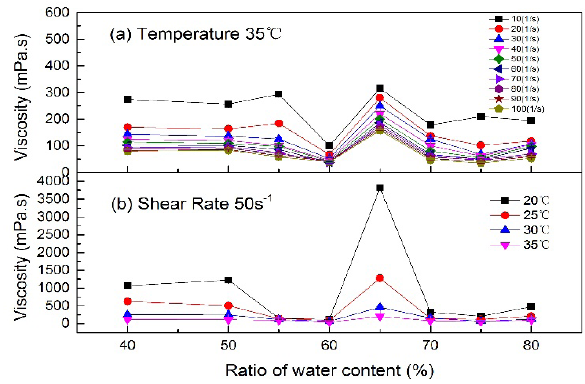
Figure 8: Dependencies of viscosity on the water content in the system of polymer concentration (708mg/L) and (a) temperature (35 ) (b) shear rate (50s-1). ℃